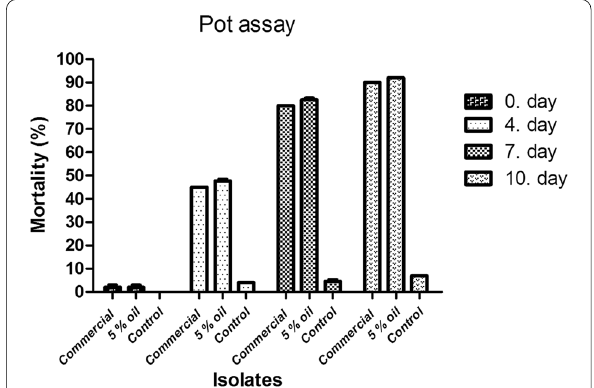
Fig. 3 Mortality rates of control group, 5% oil formulation and commercial product in lettuce seedlings against 3rd instar Helicoverpa armigera